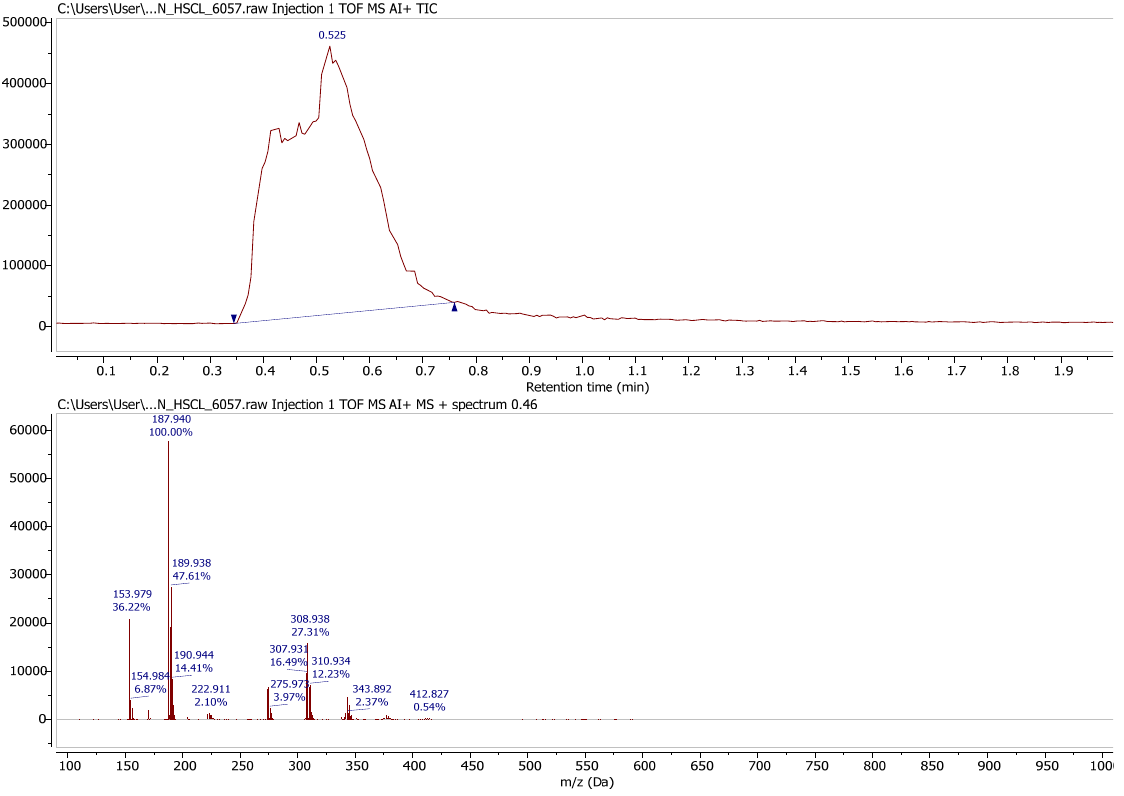
Figure 1. The full ASAP-MS spectrum obtained from the sample of ( 2 ) generated in this study according to the experimental. Y-axis is (total) ion count.